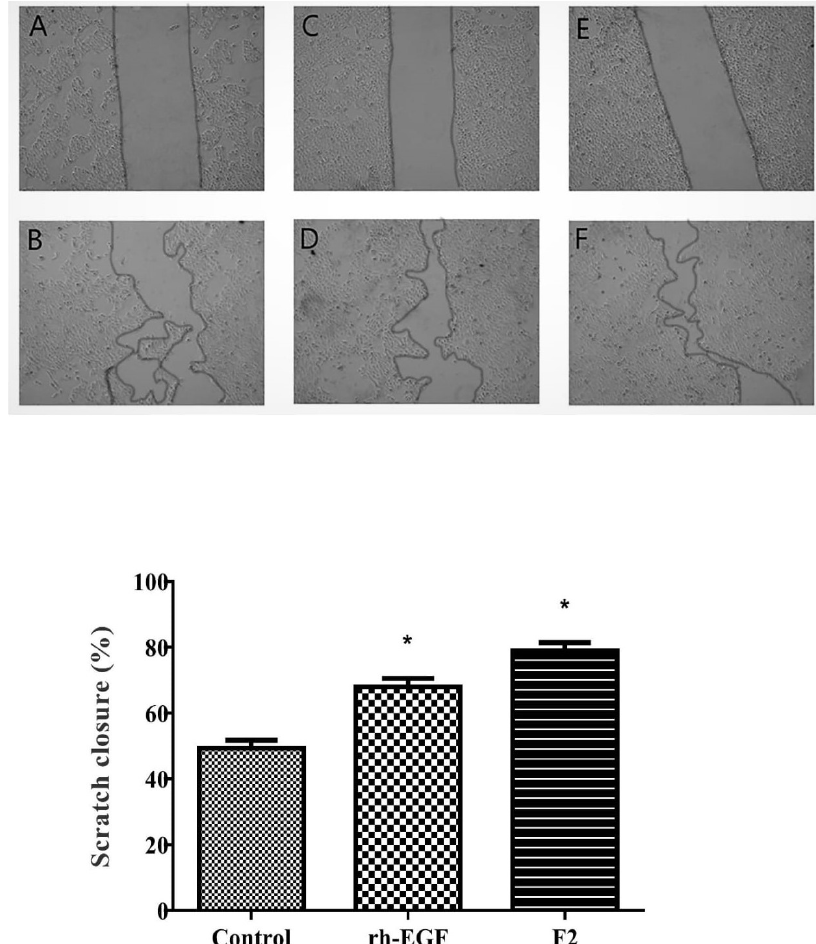
FIGURE 9 - Scratch test images of HaCaT cell. A: Control group (t:0 h), B: Control group (t:24 h), C: rh-EGF (t:0 h), D: rh-EGF (t:24 h), E: F2 formulation (t:0 h), F: F2 formulation (t:24 h). F2 was optimized formulation so we used it scratch assay. Values are mean of triplicate determination (n = 3) ± standard deviation, and statistically significant at * p < 0.05 . In these experiments the same procedure was performed in HaCaT and NIH 3T3 cell